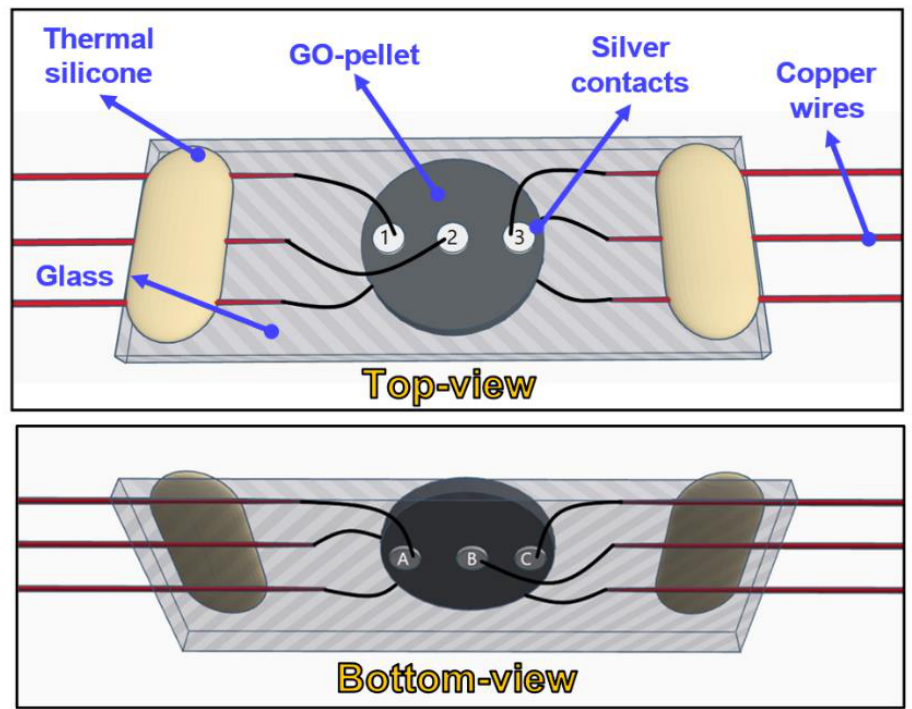
Figure 3. Schematic representation of MEG device constructed using GOP-1 as the absorbing material for evaluation of multiple contact configurations. Device top-view: three contacts labelled 1, 2, and 3. Device bottom-view: contacts labelled A, B, and C.